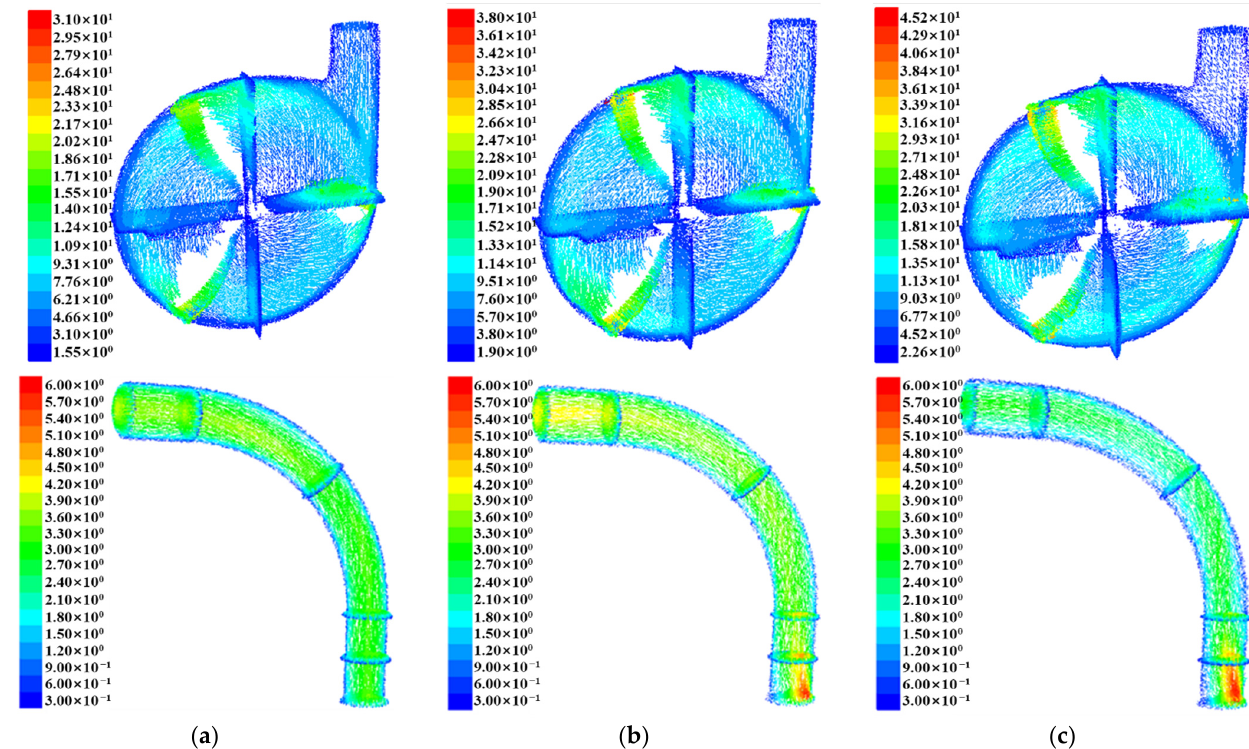
Figure 7. The v Figure 7. The velocity vector diagram of the material phase in the device with different impeller speeds. ( a ) Impeller speed was 450 r/min. ( b ) Impeller speed was 630 r/min. ( c ) Impeller speed was 810